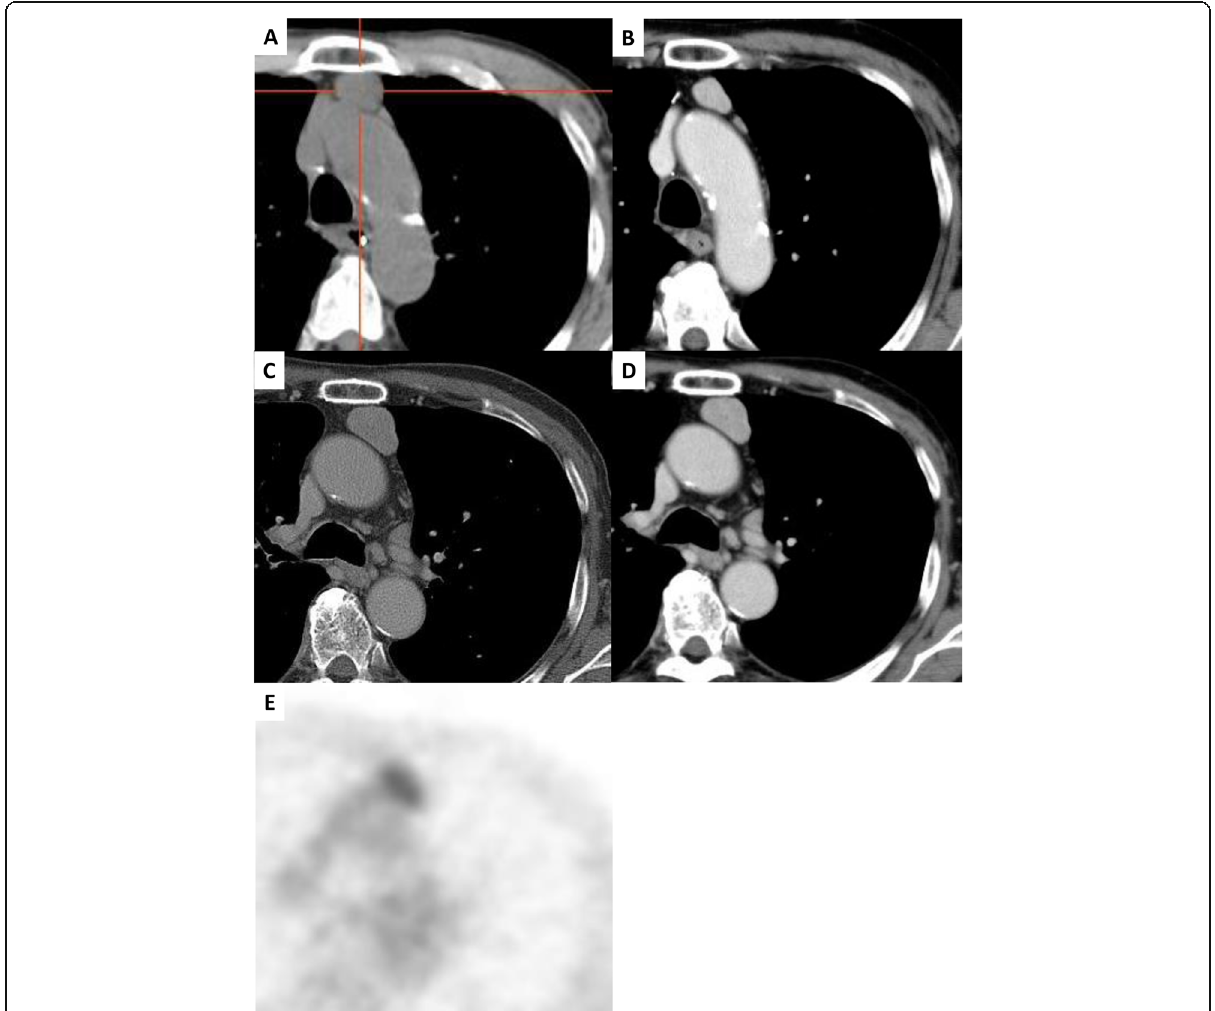
Fig. 1 Anterior mediastinal mass. Chest computed tomography (CT) revealed a 2.5-cm well-defined homogenous mass in the anterior mediastinum at the time of diagnosis with autoimmune pancreatitis ( a ), and the tumor decreased in size to 2 cm on CT with oral steroid treatment 6 years ago ( b ). The tumor had regrown to 3 cm at the time of referral to our department on CT ( c , d ), and positron emission tomography showed a high maximum standardized uptake of 3.6 by the anterior mediastinal mass lesion ( e